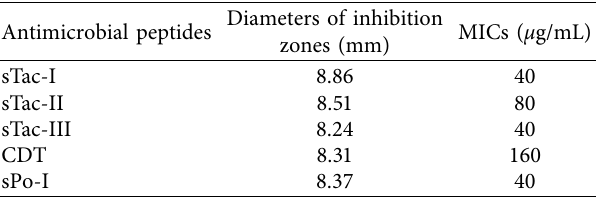
Table 3: Te diameters of the inhibition zones produced by the fve sLAMPs and the MICs of the synthetic antimicrobial peptides.